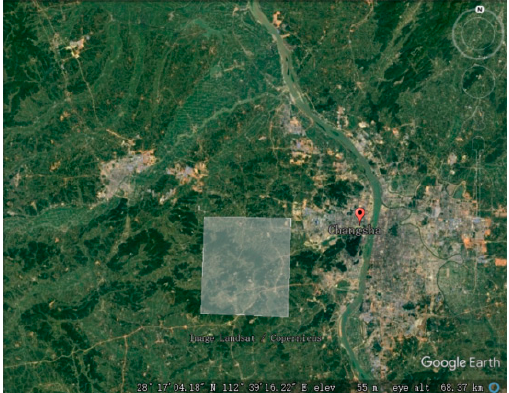
Figure 25. The region of interest (ROI) considered is denoted by the semitransparent polygon.